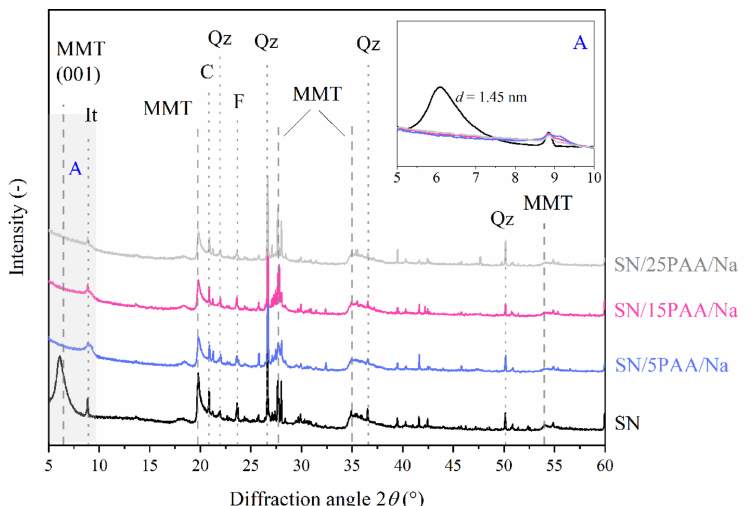
Figure 6. X-ray diffraction patterns of unmodified bentonite SN and modified with poly(acrylic acid) sodium salt bentonite SN/PAA/Na with distinction into the polymer content (MMT— montmorillonite, It—illite, C—calcite, Qz—quartz, F—feldspar). The A area is a magnification of the XRD pattern in the angle range of 5–10 ◦